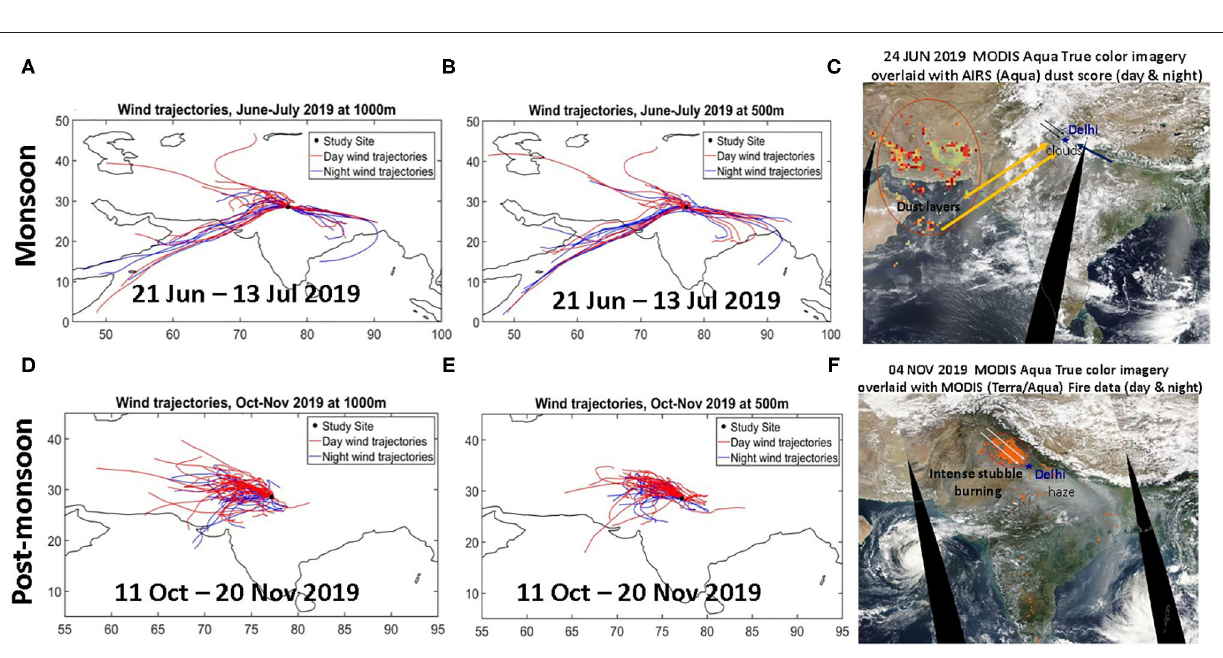
be attributed to local biomass burning (in addition to